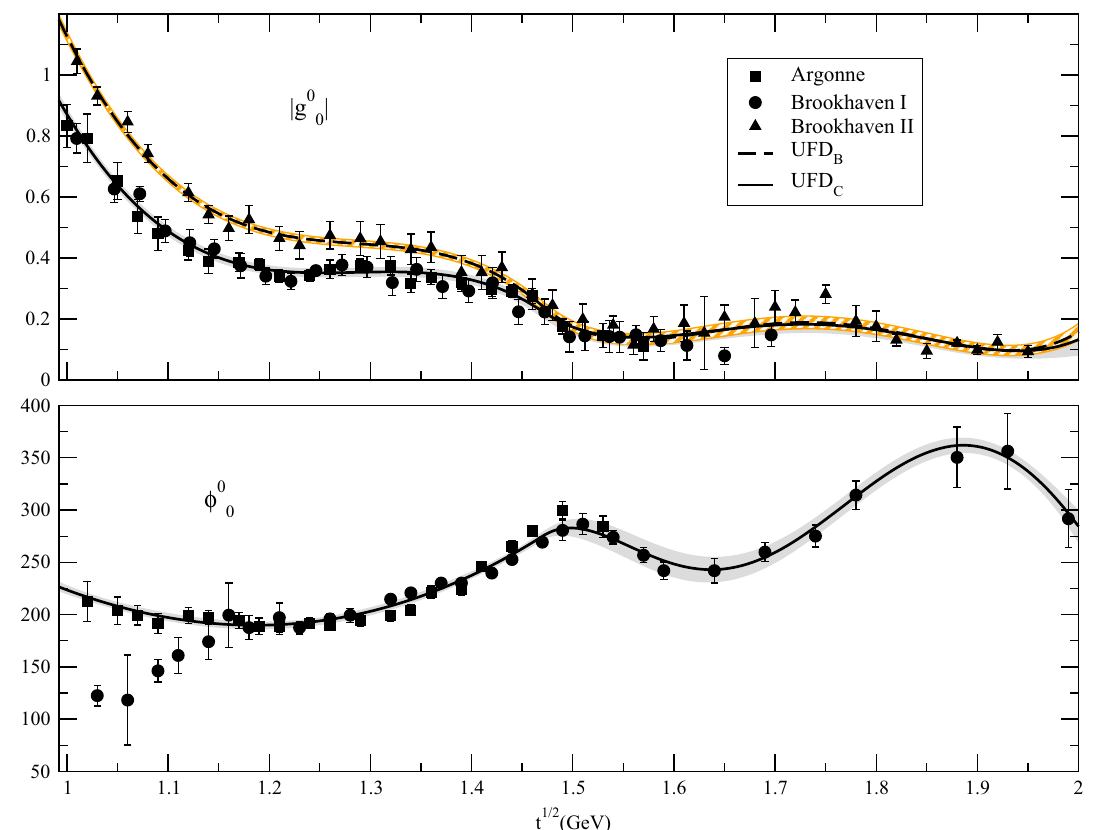
whichiscommonforbothUFD B andUFD C .NotethattheBrookhaven- I phase close to threshold lies around 150 ◦ or below, at odds with all dispersiveanalysisof ππ scattering,whichfindaphasearoundorabove 200